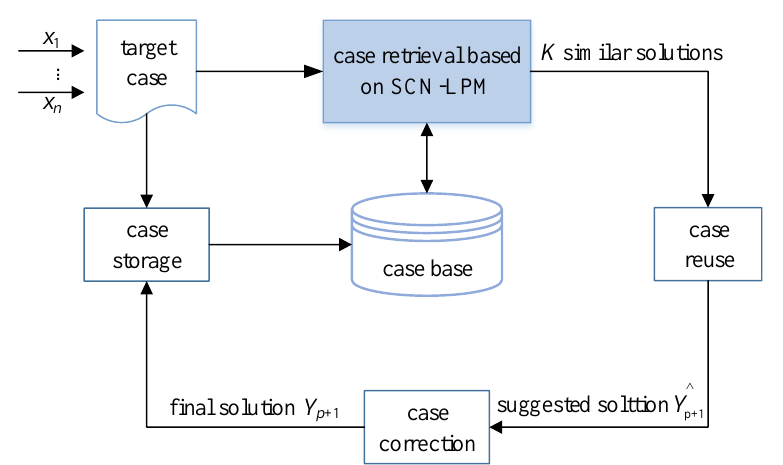
Figure 2. Fault detection model based on SCN-CBR.